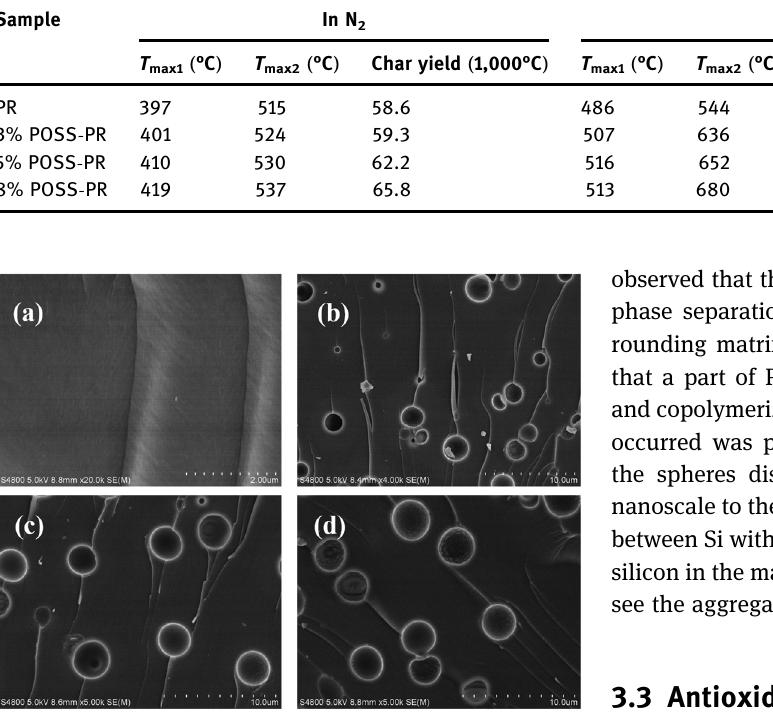
Figure 13: SEM images of the cured product of: ( a ) PR, ( b ) 3% POSS - PR, ( c ) 5% POSS - PR, ( d ) 8% POSS - PR.